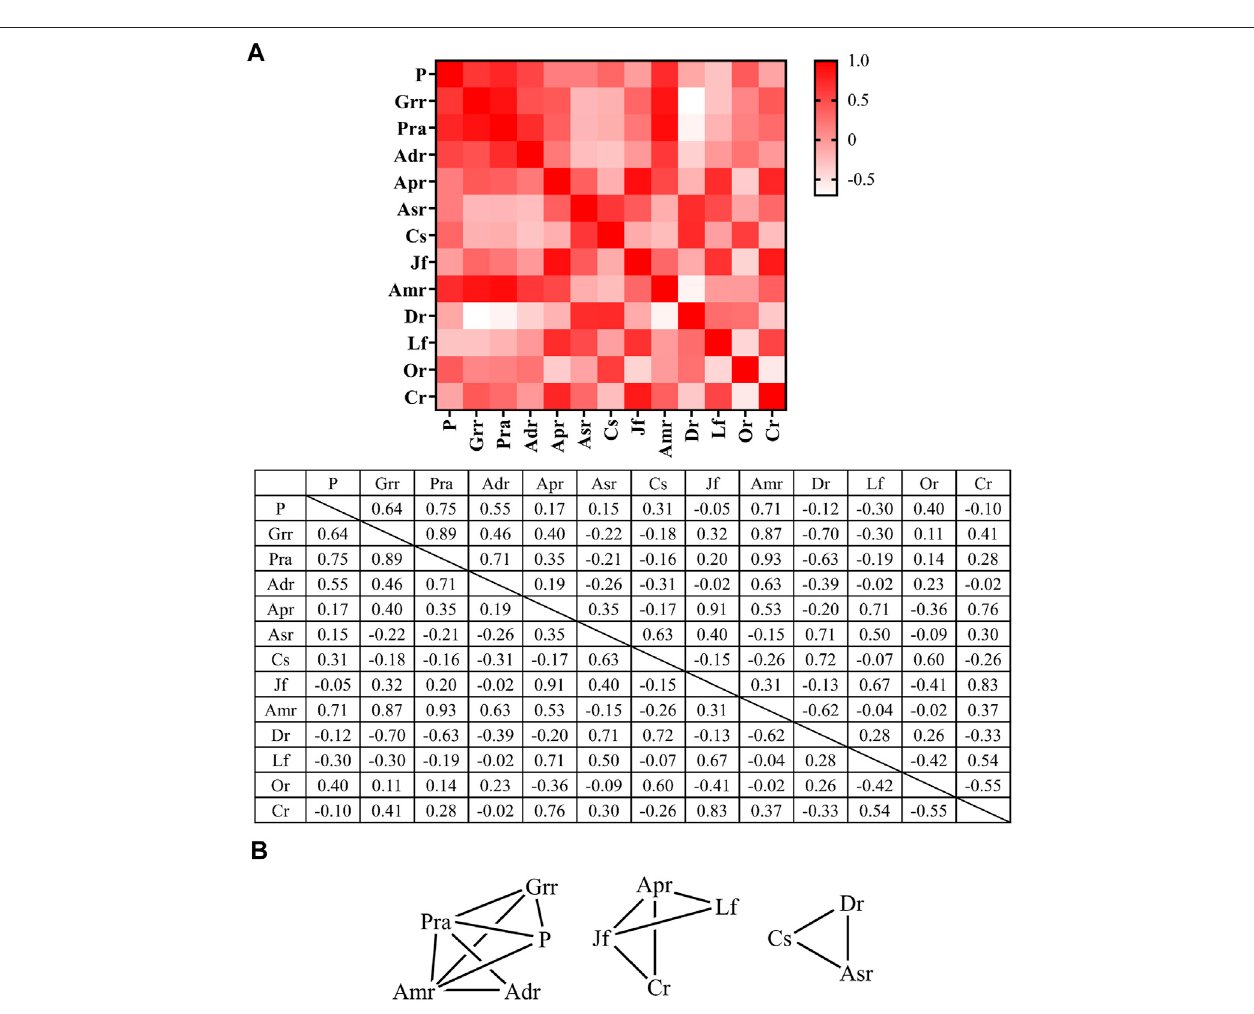
FIGURE 7 | Spearman correlation analysis of commonly used medicinal materials used in oral skin whitening prescriptions. (A) Heat map and (B) Network map. Adr, Angelica dahurica (Hoffm.) Benth. & Hook. f. ex Franch. & Sav.; Amr, Atractylodes macrocephala Koidz.; Apr, Astragalus propinquus Schischkin; Asr, Angelica sinensis (Oliv.) Diels; Cr, Ligusticum striatum DC.; Cs, Coix lacryma-jobi var. ma-yuen (Rom.Caill.) Stapf; Dr, Dioscorea polystachya Turcz.; Grr, Glycyrrhiza uralensis Fisch.; Jf, Ziziphus jujuba Mill. (red); Lf, Lycium chinense Mill.; Or, Ophiopogon japonicus (Thunb.) Ker Gawl.; P, Wol fi poria extensa (Peck) Ginns; Pra, Paeonia lacti fl ora Pall.